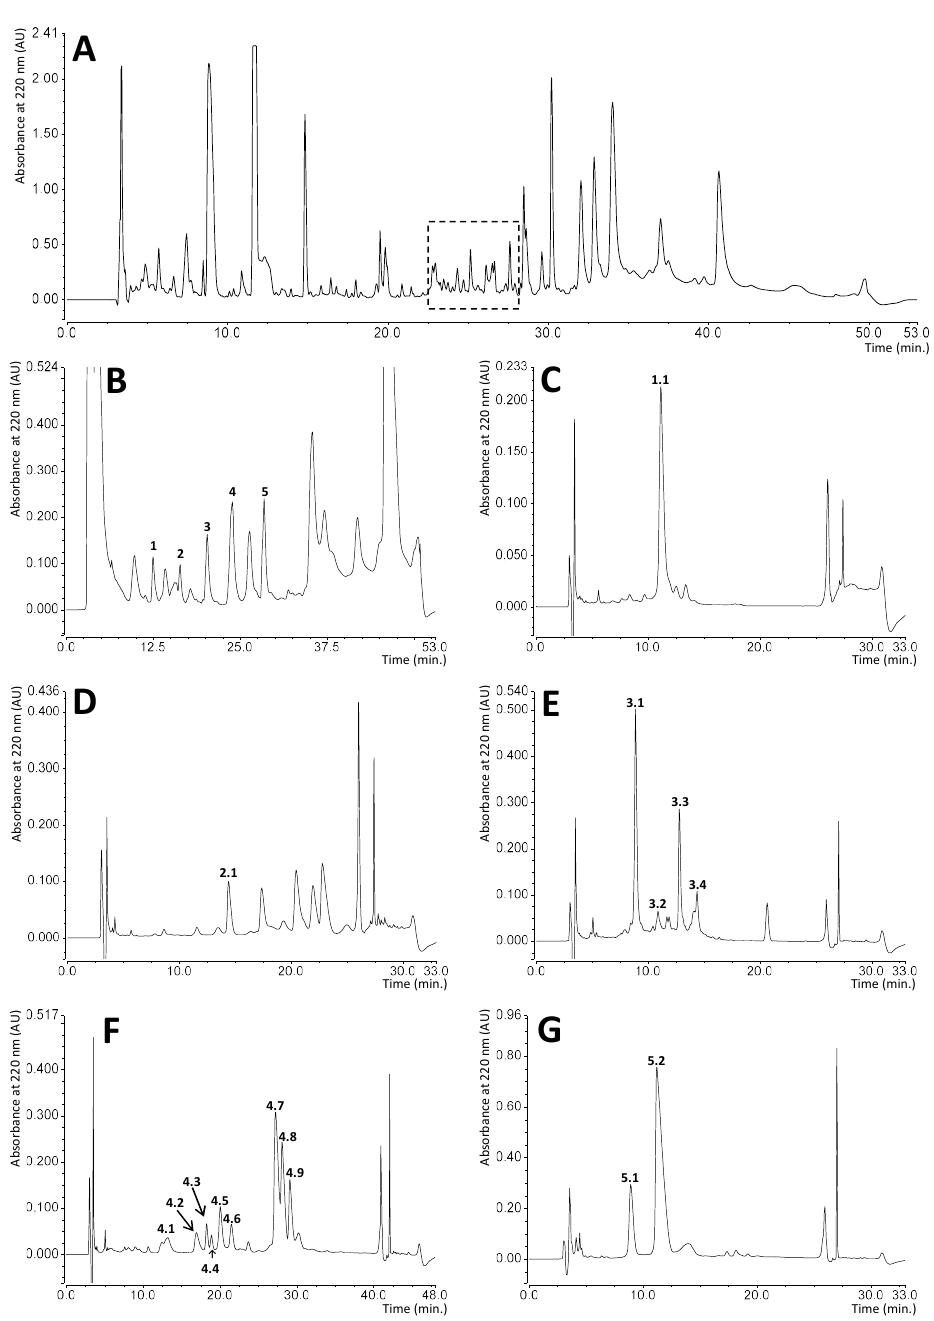
Figure 1. Reversed-phase high pressure liquid chromatography (RP-HPLC) of the components of the hemolymph of immunized insects. Panel ( A ) shows the full elution profile of the hemolymph. All visible peaks form this separation were collected and tested for antibacterial activity against Escherichia coli and Staphylococcus intermedius. The dashed square indicates the region with the highest activity. Panel ( B ) presents further separation of this specific region into several fractions. Of these fractions, five peaks marked from 1 to 5 had bactericidal activity. Panels ( C – G ) show individual separations of these fractions into subfractions containing homogeneous compounds. Those exhibiting bactericidal activity are marked with double digit numbers and were used for further SDS-PAGE analysis and identification. The details of hemolymph collection and chromatography conditions are described in the Materials and Methods